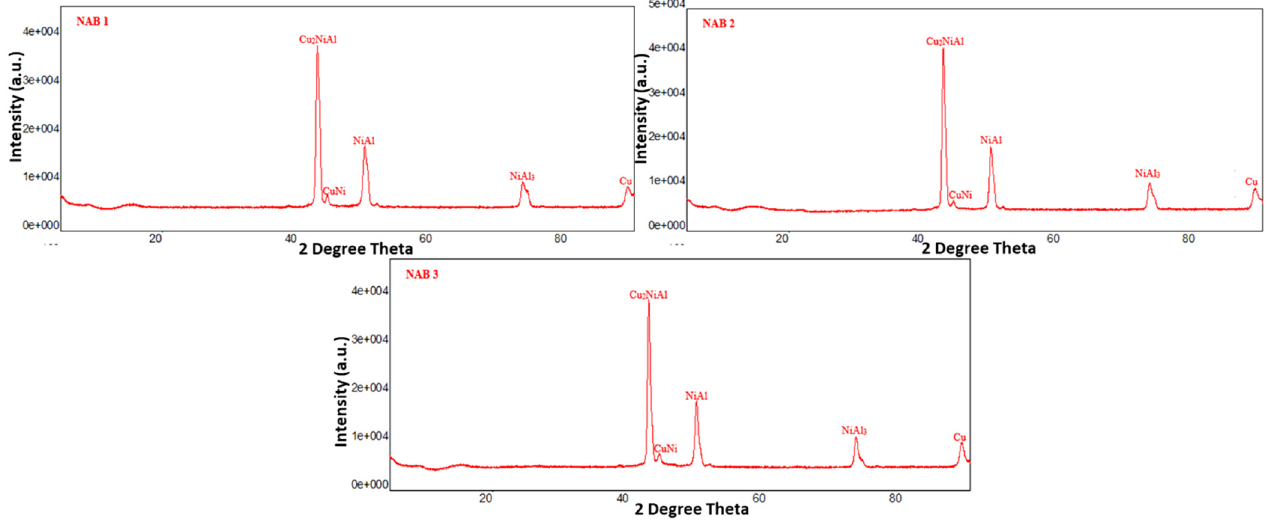
Fig. 5. XRD results of the sintered NAB